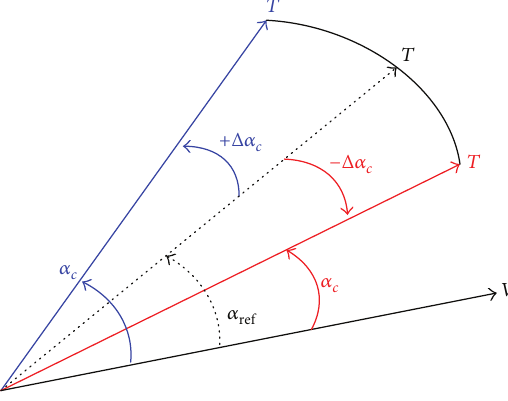
Figure 5: Schematic of thrust bias energy